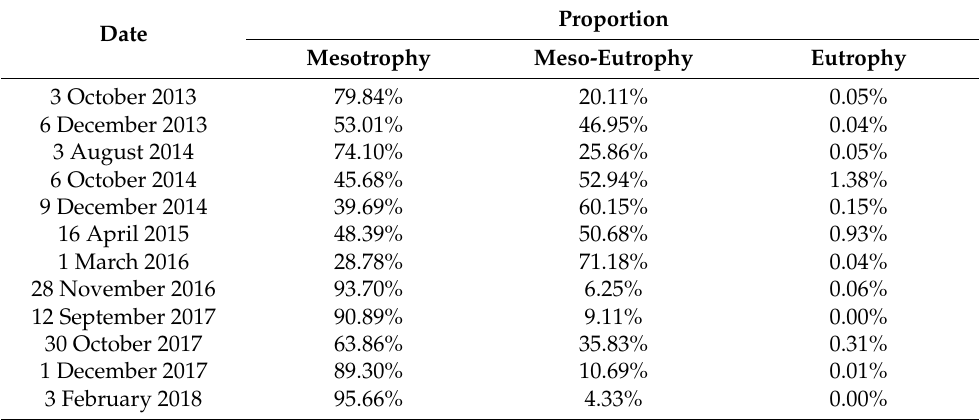
Table 7. Area proportion of trophic condition in different periods at Dashahe